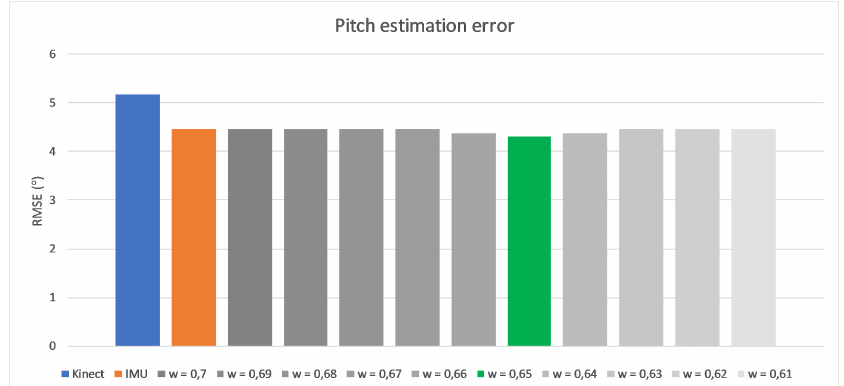
Figure 15. Influence of w ψ to the pitch rotation estimation